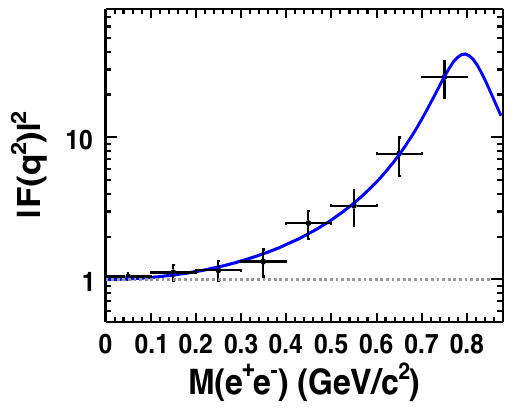
Figure 6: The TFF of η (cid:48) from the BESIII experiment using Dalitz decay process. The dot with error bars are the measurement and the blue curve is the fit result with the single pole approximation.